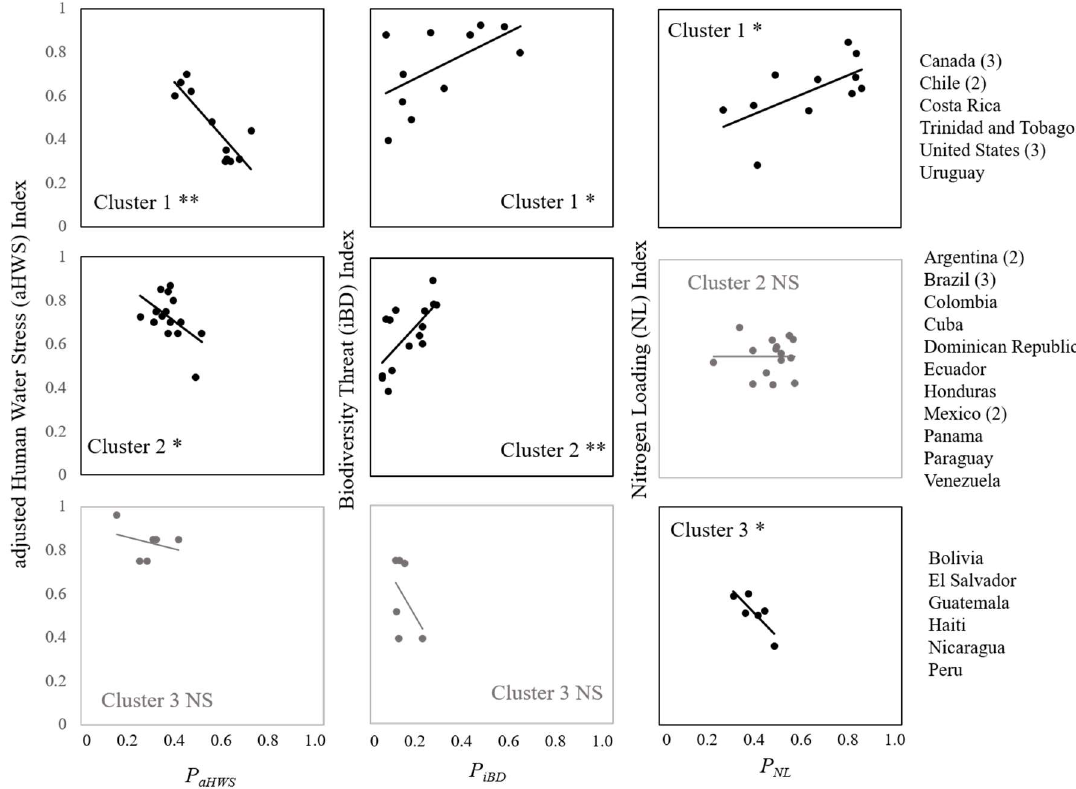
Figure 7. Three-category threat benchmark proxy regression outcomes for Ramsar sites clustered by national GDPP and access to advanced sanitation. Plots are for water supply (aHWS), biodiversity-related (iBD), and nutrient regulation (NL) threats (left to right) for higher, intermediate and lower development levels (top to bottom). (Significance levels: ** p < 0.01; * p < 0.05; NS = not significant; see Table A2 for regression results).